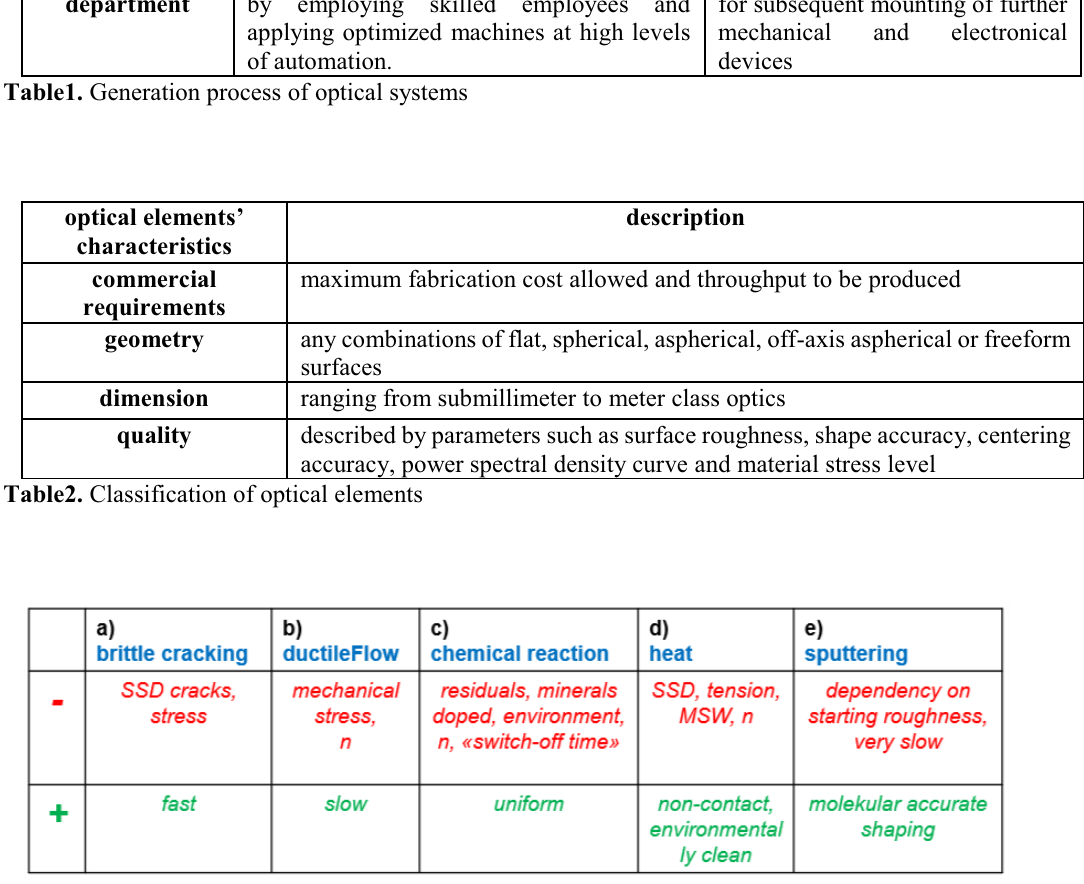
Fig.3. Optical polishing techniques consist of combinations of five wear processes , each with its strong (“+” and weak (“-“) characteristics in terms of generating optical elements.